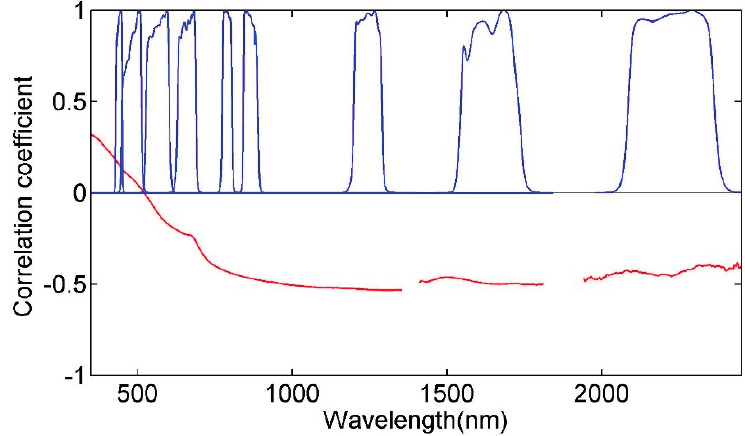
Figure 2. Correlation relationship between soil salinity and field spectra data (red lines). ALI relative spectral functions were superimposed to illustrate the positions of ALI spectral bands (blue